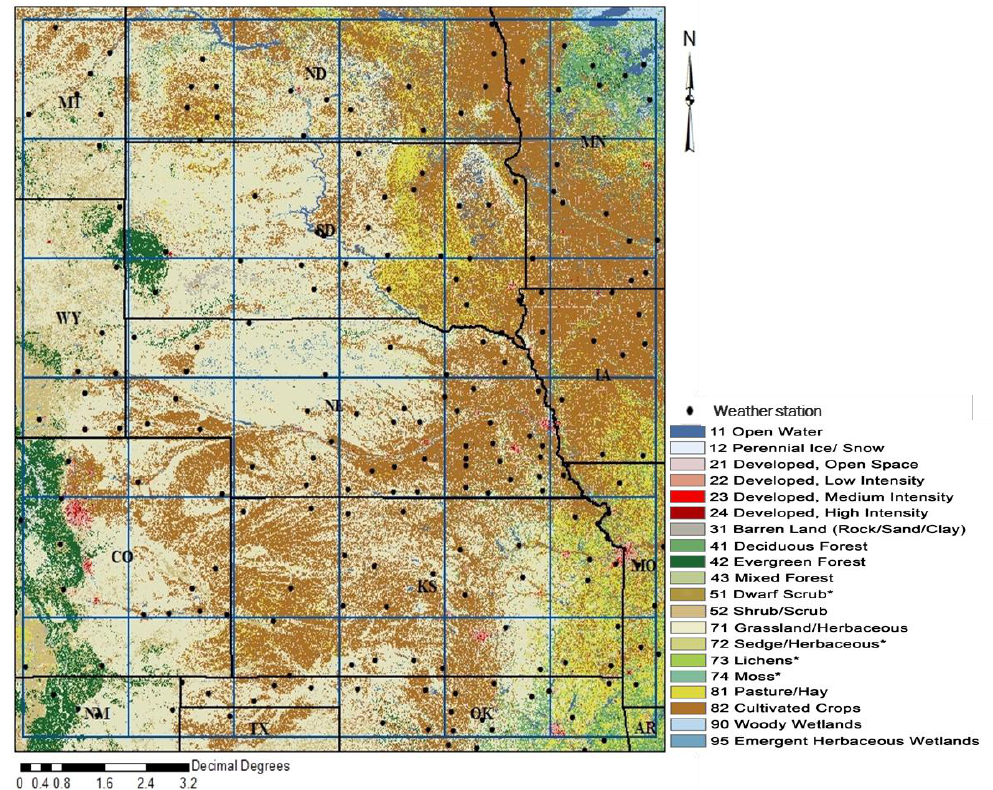
Figure 1. Map showing the study region, High Plains, the landcover during the year 2006 (Source: National Land Cover Database, and the weather stations (black dots) used in the